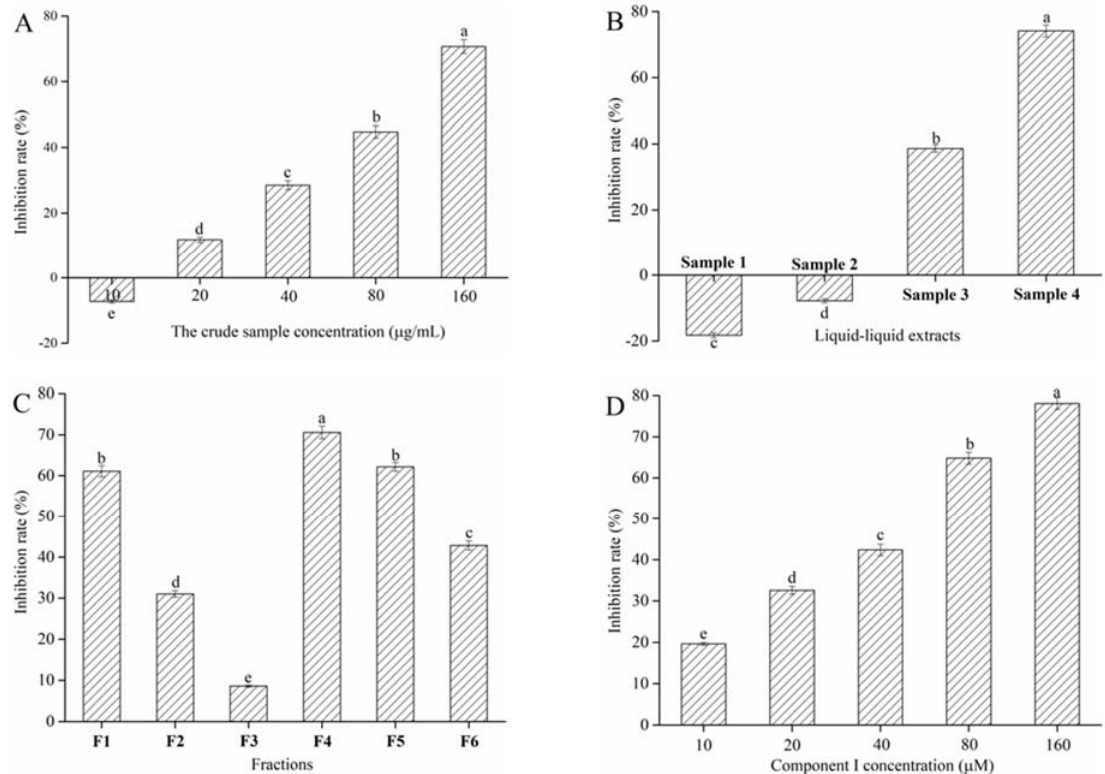
Figure 1. Effect of the crude sample ( A ), liquid–liquid extracts ( B ), counter-current fractions ( C ), and Cyanidin-3-glucoside (C3G) ( D ) from blueberry on α‐ glucosidase inhibition rate. Different lowercase letters indicate significant difference ( p < 0.05).